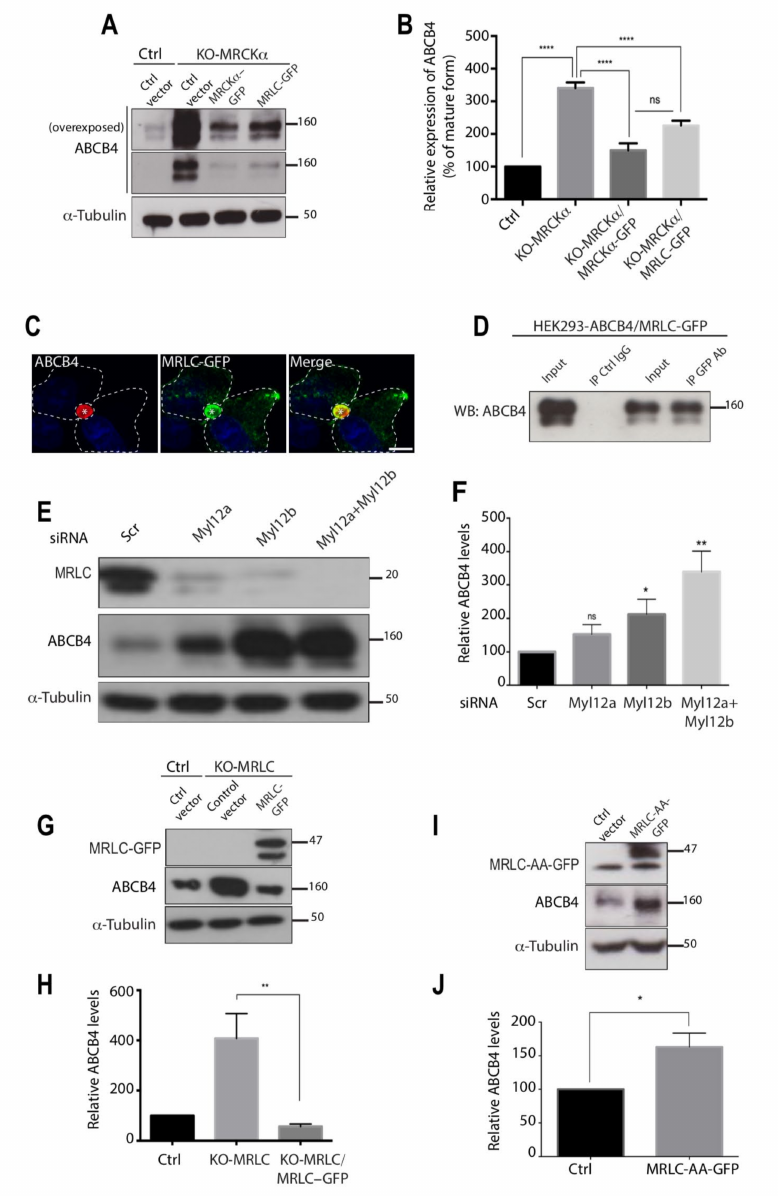
Figure 5. Impact of MRLC depletion on ABCB4 protein expression. ( A ) HEK-293 Ctrl or KO-MRCK α were transfected with the ctrl vector or with either MRCK α -GFP or MRLC-GFP. After 24 h, they were transfected with ABCB4-wt for an additional 24 h and analyzed by immunoblotting. The top panel shows a long immunoblot exposure for ABCB4. ( B ) ABCB4 levels were expressed as a percentage of total expression in control HEK-293 cells transfected with the control vector. Means ( ± SD) of at least four independent experiments are shown. **** p < 0.0001. ( C ) ABCB4 staining in HepG2 cells transiently expressing ABCB4 and MRLC-GFP was performed as in Figure 1B. ( D ) Cell lysates of co-transfected HEK-293 cells with plasmids expressing ABCB4 and GFP-tagged MRLC were incubated with anti-GFP antibody or mouse immunoglobulin G (IgG), covalently linked to agarose beads. The immunoprecipitated complex was immunoblotted with anti-ABCB4 antibody. The input indicates the presence of ABCB4 in the cell lysate. ( E ) HEK-293 cells stably expressing ABCB4 were transfected with control siRNA or siRNA of the two isoforms Myl12a and